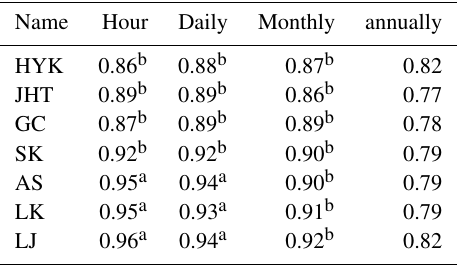
Table 3. Hurst value of